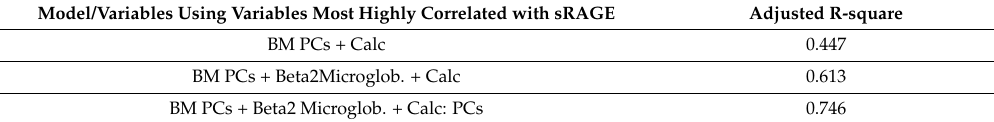
Table 2. Microglobulin, bone marrow plasma cells, and the interaction between calcemia and bone marrow plasma cells were the best combination of model variables which significantly predicted